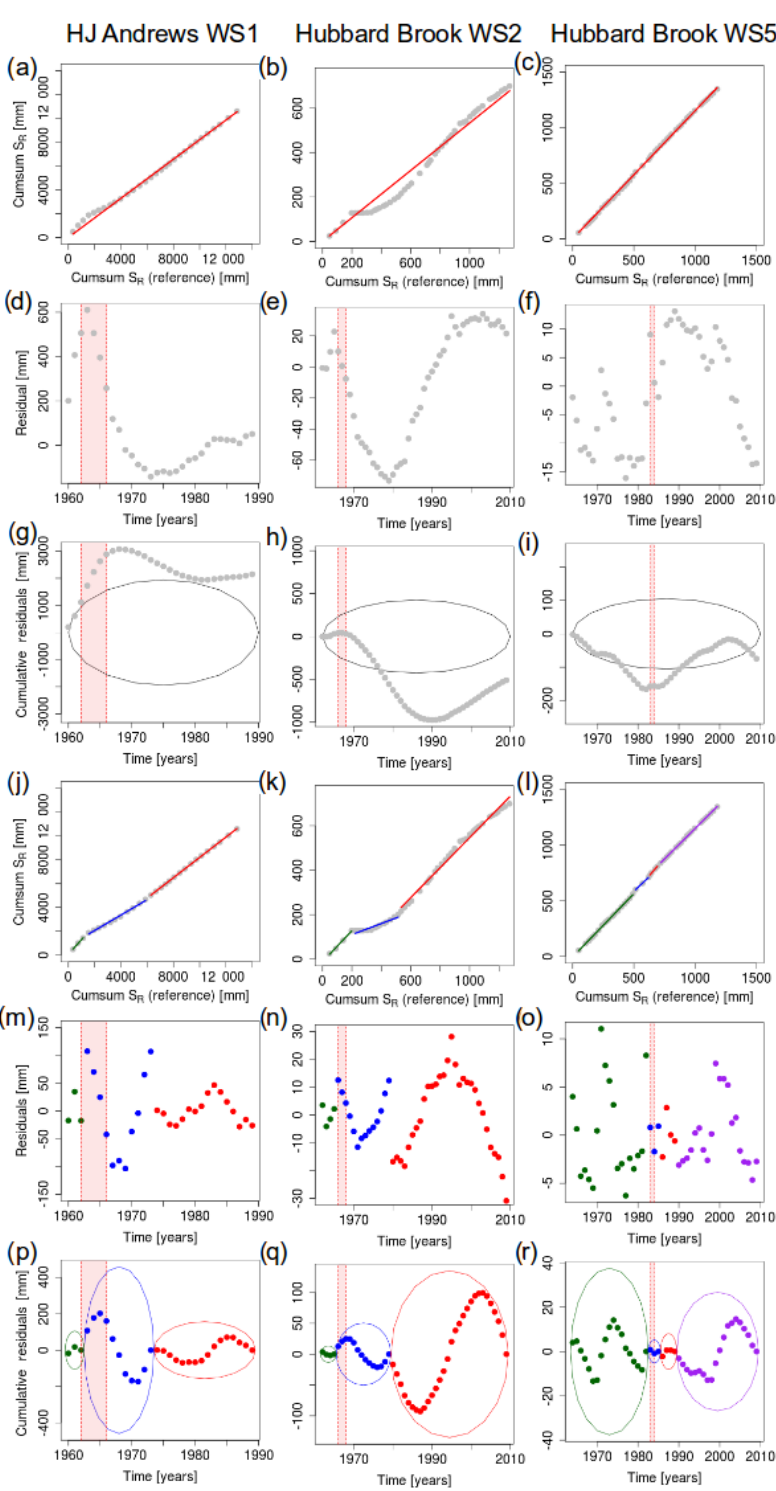
Figure 7. Trend analysis for S R,1yr in HJ Andrews WS1, Hubbard Brook WS2 and WS5 based on comparison with the control watersheds with ( a – c ) cumulative root-zone storages ( S R,1yr ) with regression, ( d – f ) residuals of the regression of cumulative root-zone storages, ( g – i ) significance test; the cumulative residuals do not plot within the 95%-confidence ellipse, rejecting the null-hypothesis that the two time series are homogeneous, ( j – l ) piecewise linear regression based on break points in residuals plot, ( m – o ) residuals of piecewise linear regression, ( p – r ) significance test based on piecewise linear regression with homogeneous time series of S R,1yr . The different colours (green, blue, red, violet) indicate individual homogeneous time